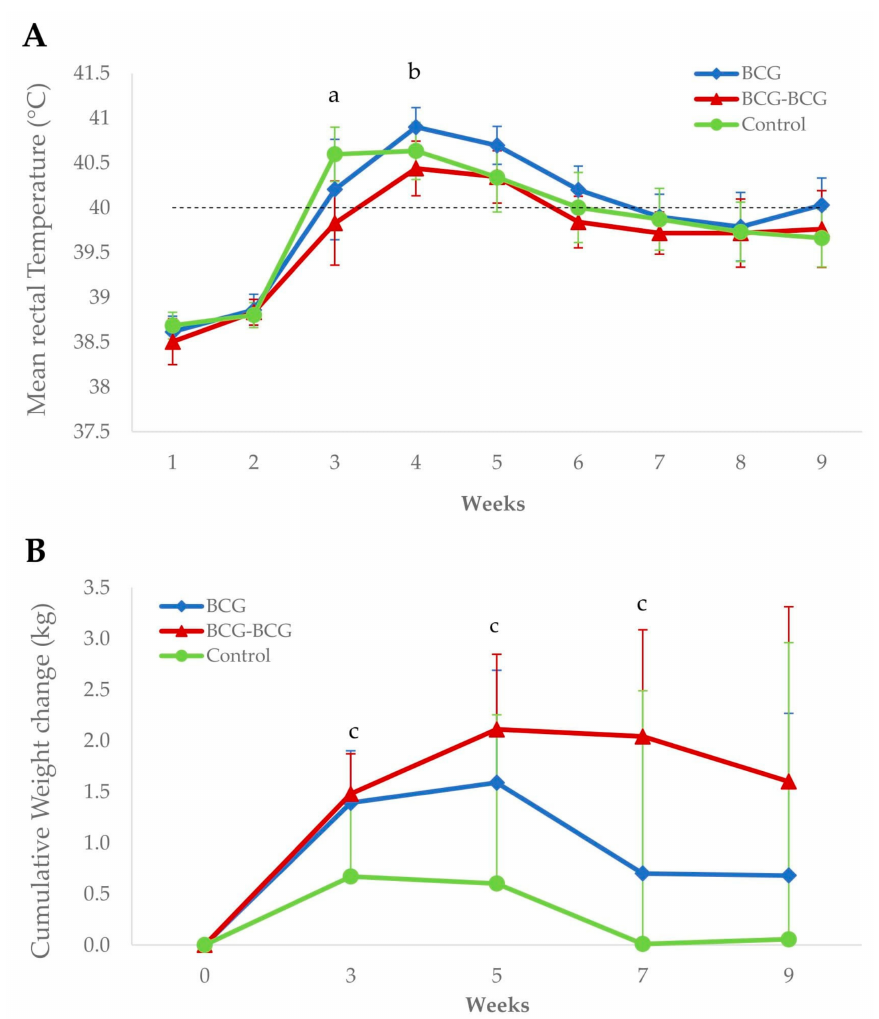
Figure 5. Clinical signs after M. caprae challenge. ( A ) Mean rectal temperatures per group. BCG (blue): single BCG-vaccinated group, BCG-BCG (red): BCG revaccinated group, Control (green): Unvaccinated group. Dashed line: fever threshold (40 ◦ C). (a) BCG-BCG compared to Control, p < 0.05; (b) BCG-BCG compared to BCG, p < 0.05. ( B ) Mean cumulative weight changes per group. (c) BCG-BCG compared to Control, p < 0.05; LMER with pairwise